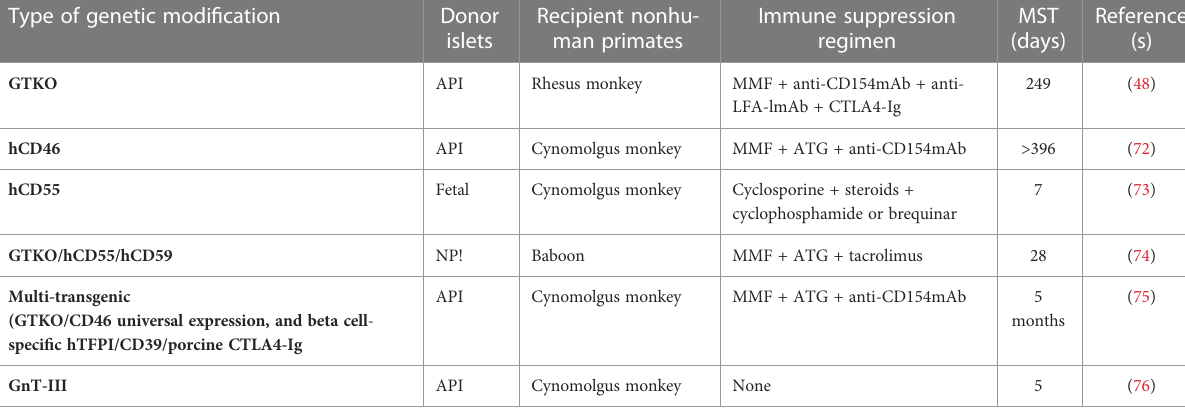
TABLE 2 Exploring genetic modi fi cation in donor pig islets with immune suppression regimen to increase the post-transplantation survival time. Type of genetic modi fi